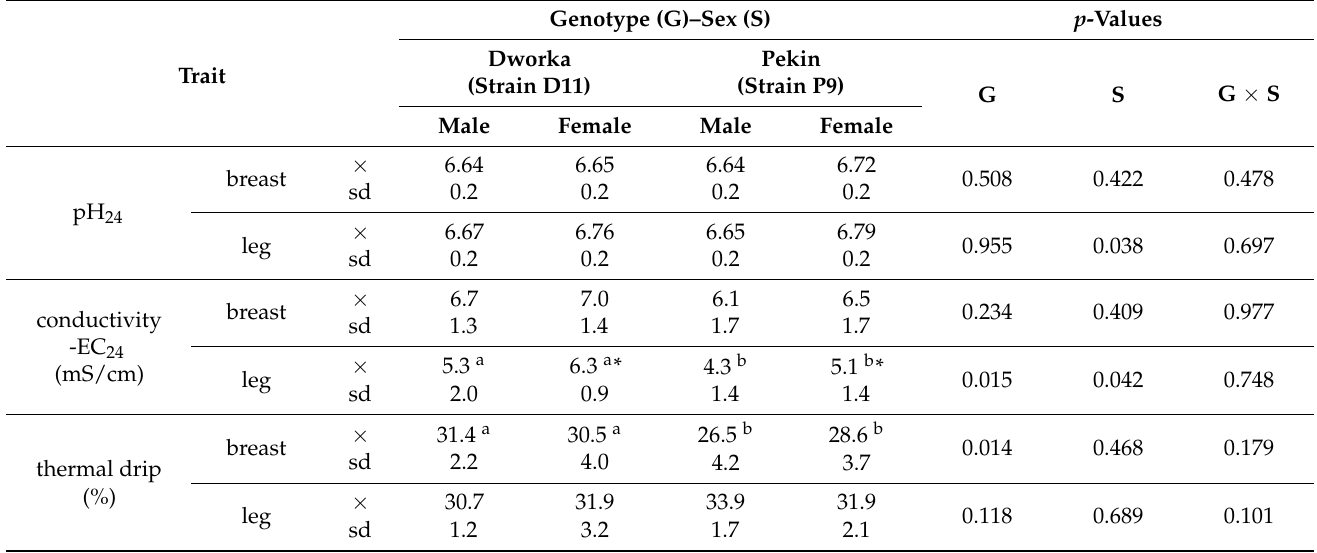
Table 3. Mean values ( × ) and standard deviation (sd) of selected physicochemical characteristics of the breast muscles and legs of 113-week-old